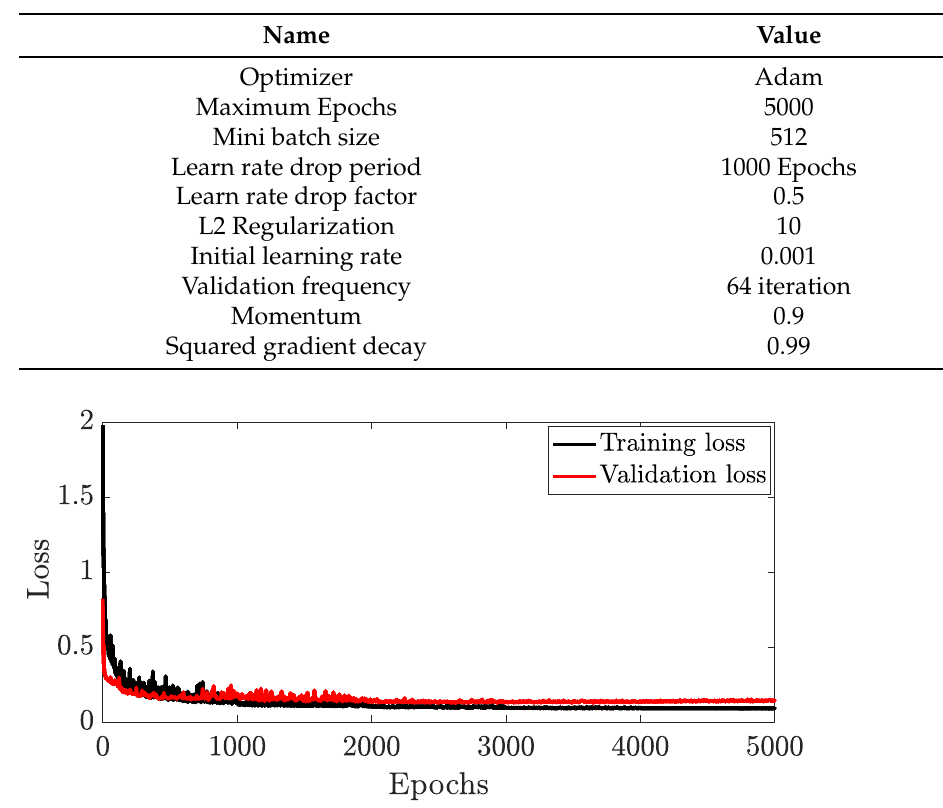
Table 2. Specification of training the proposed deep network to predict performance and emission.